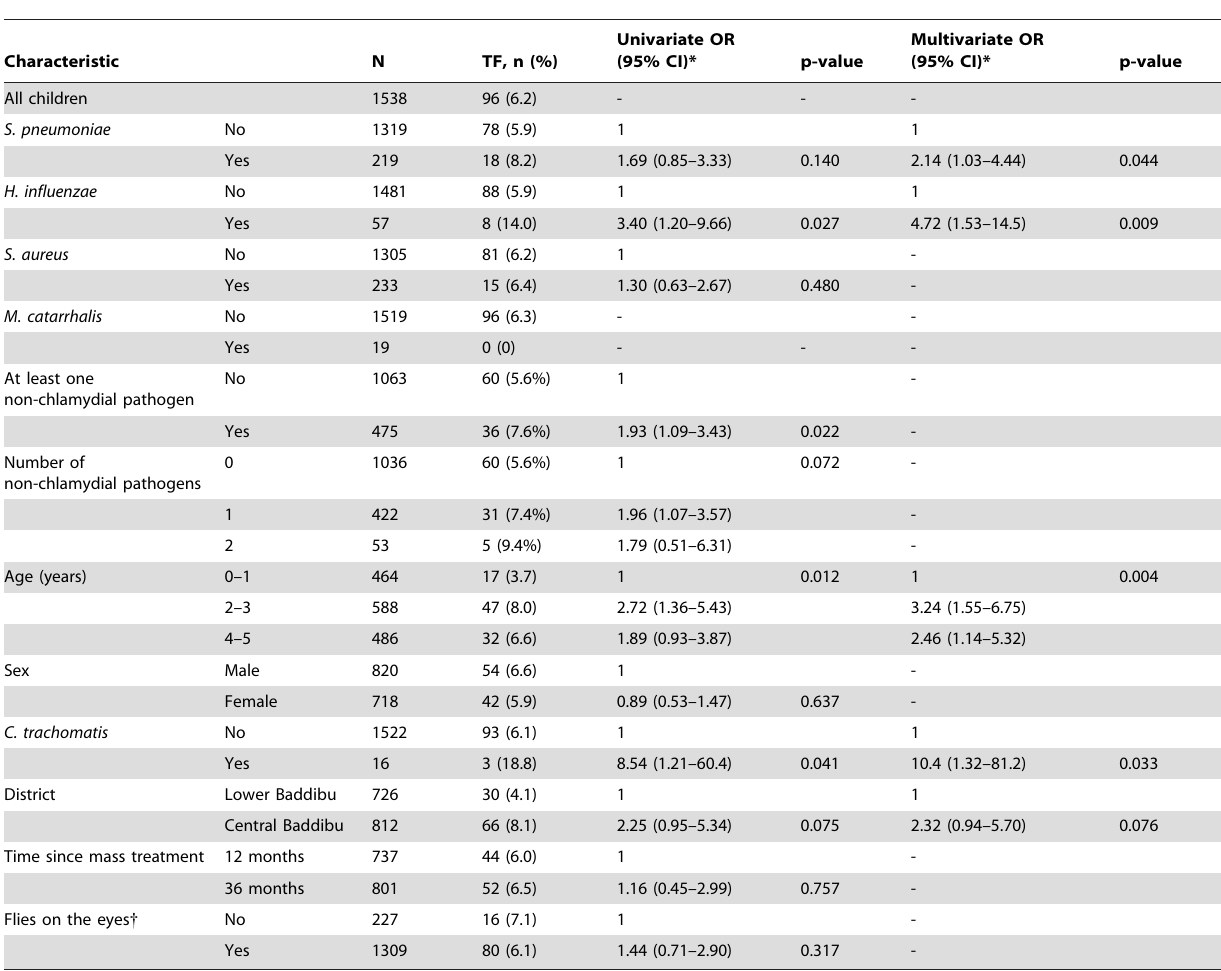
Table 2. Associations between bacterial pathogens and TF in 0–5 year